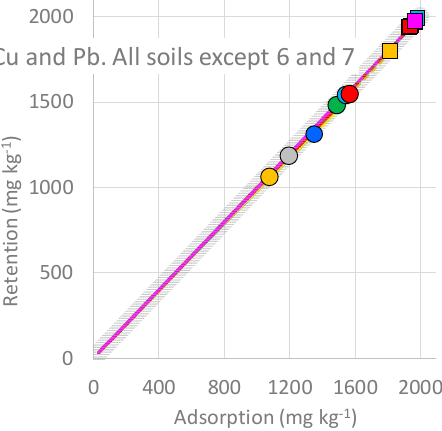
Cu : circles show the highest retention/adsorption ratio and continous line the rest of the concentrations. Pb : squares show the highest retention/adsorption ratio and dotted lines the rest of the concentrations. S1 : green. S2 : light blue. S3 : dark yellow. S4 : grey. S5 : dark blue. S8 : light yellow. S9 : red. S10 : pink.